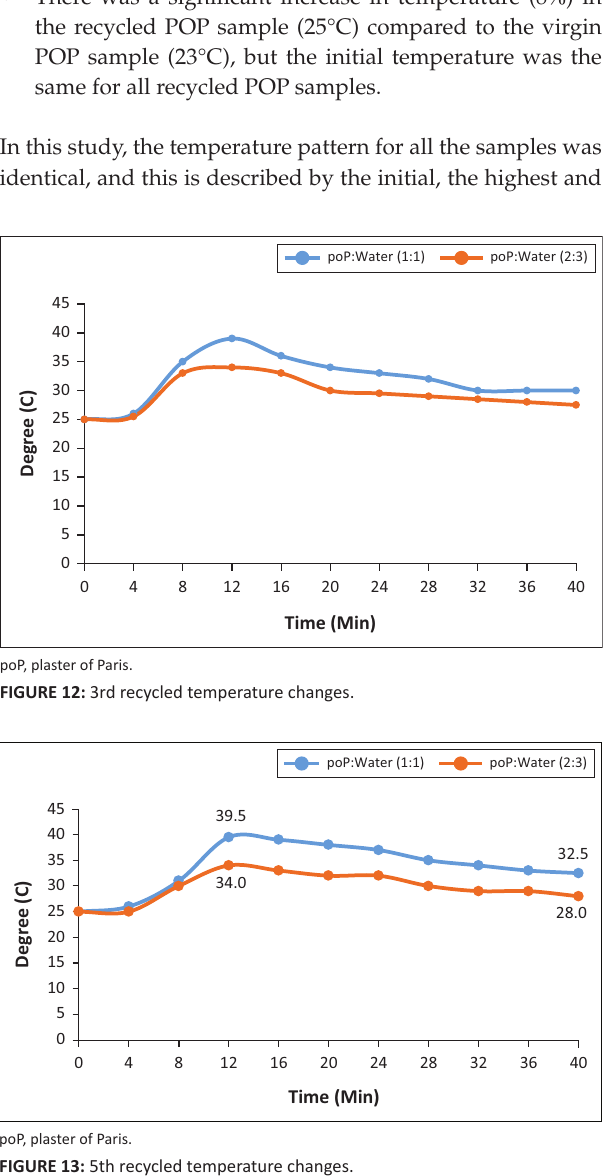
FIGURE 13: 5th recycled temperature